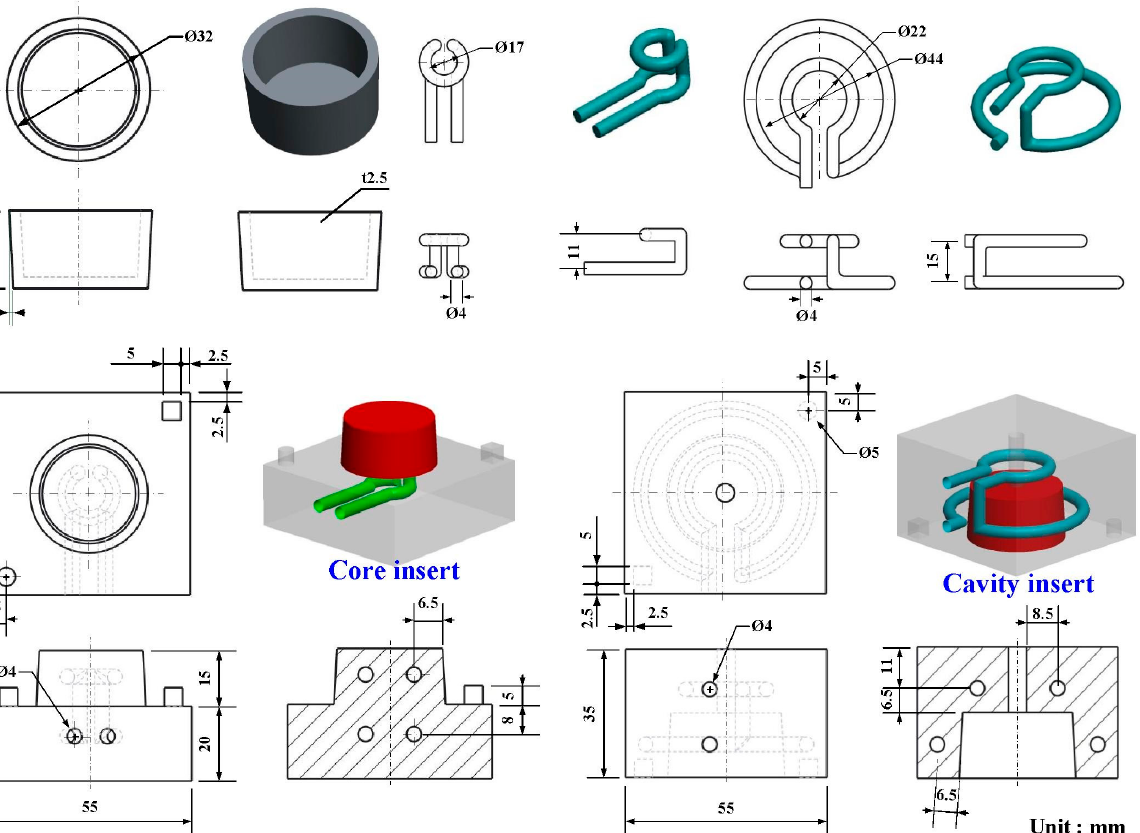
Figure 4. An in-house cooling time measurement system.